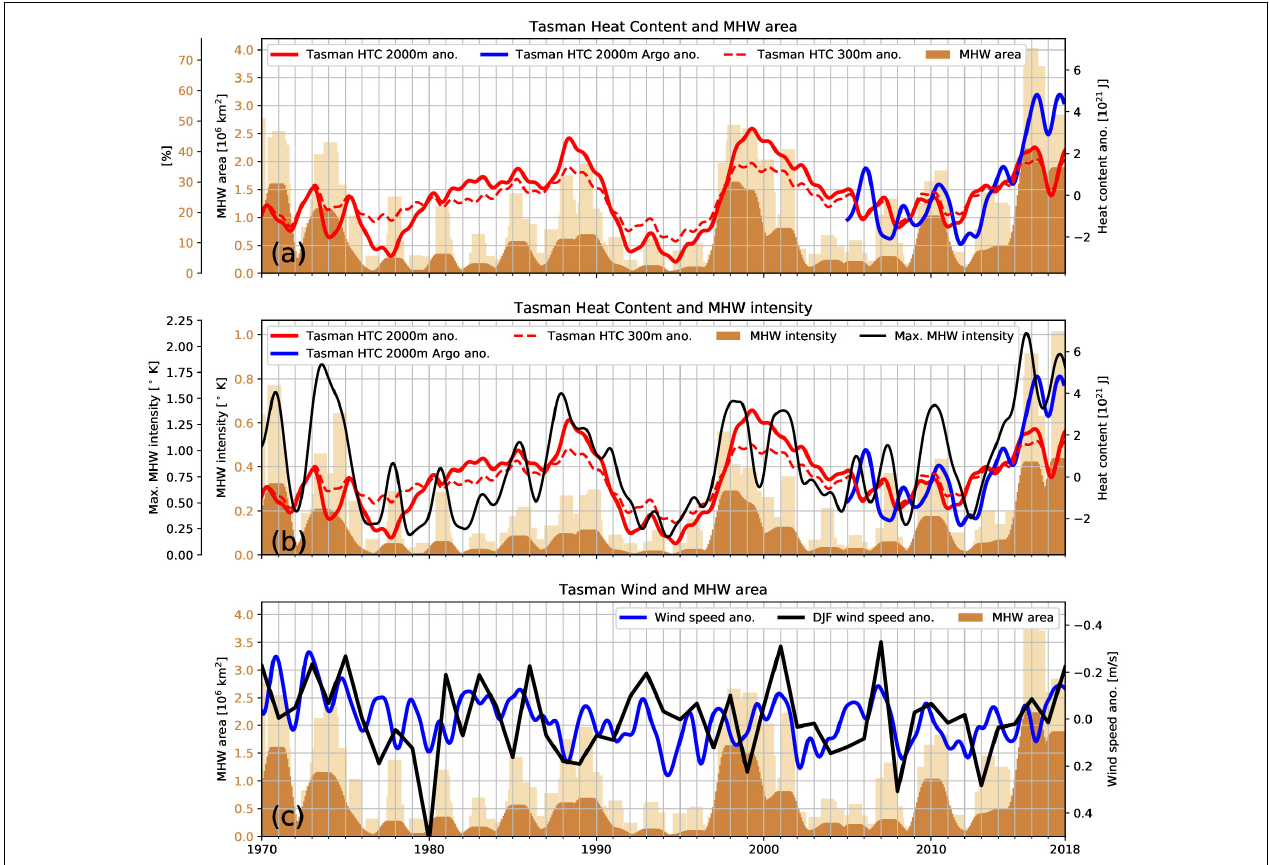
FIGURE 10 | Link between depth-integrated Tasman Box heat content and occurrence of MHWs in the Tasman Sea. (a) Upper 2000 m (300 m) heat content in red (red dashed) and area (in 10 6 km 2 ) identified as marine heatwave as light brown bars (monthly means) and fraction (%) of the Tasman Box (inner and outer left hand y scales). Dark brown area is MHW area interannually filtered. The Argo-derived heat content anomaly is shown in dark blue. (b) As for (a) , but area-averaged MHW intensity represented by light brown bars (monthly means) and interannually filtered dark brown. Black line shows the maximum MHW intensity over the Tasman Box. (c) Area averaged wind speed and December-January-February (DJF) mean anomalies (in blue and black, respectively) and total area identified as in marine heatwave conditions in (light) brown as in (a) . All time series have been interannually filtered, except the light brown monthly MHW data and DJF wind anomaly in (c)